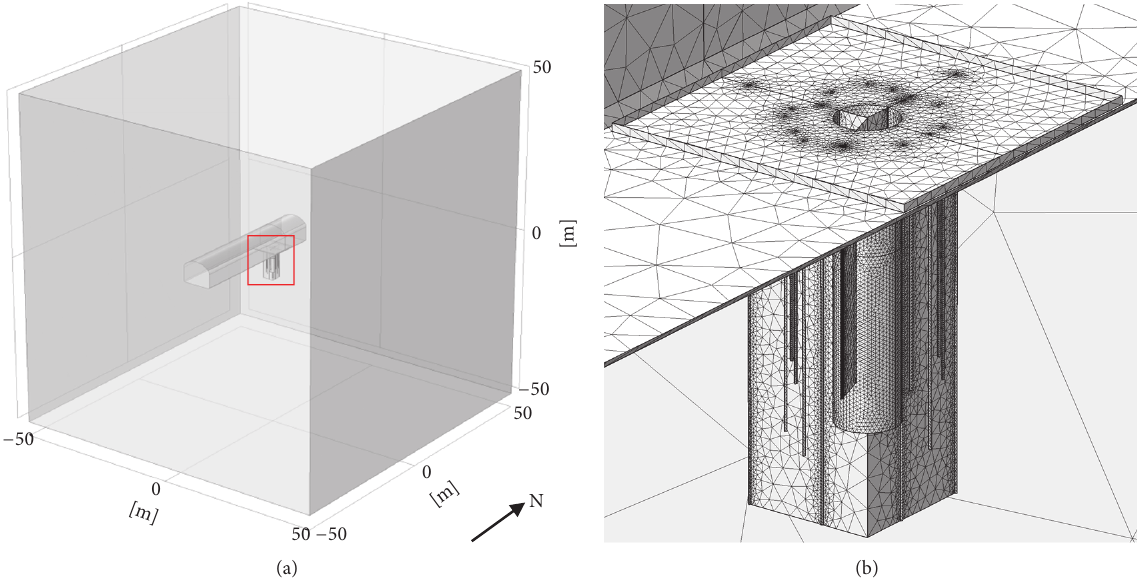
Figure 8: Rock mass block (100 m × 100m × 100 m) housing the POSE niche and the experiment area (a) and mesh detail showing the three mesh guidance planes